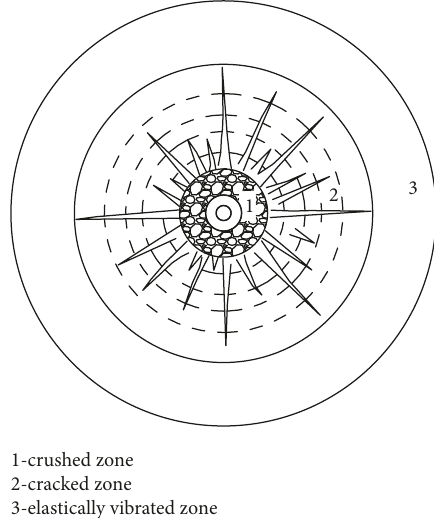
Figure 1: Divisions induced by blasting in an infinite rock